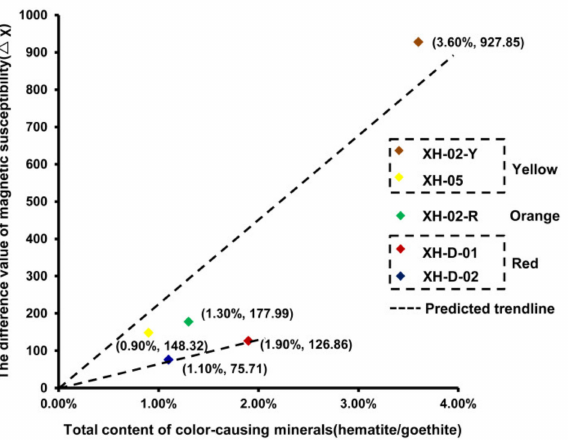
Figure 5. The relationship between total content of hematite and/or goethite and the different values of susceptibility of unit mass samples before and after the χ -T